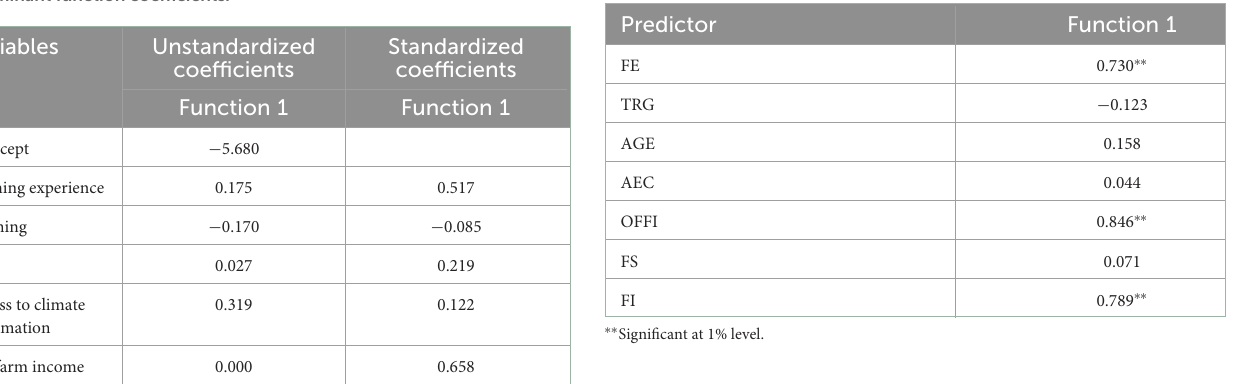
TABLE 7 Structure matrix.